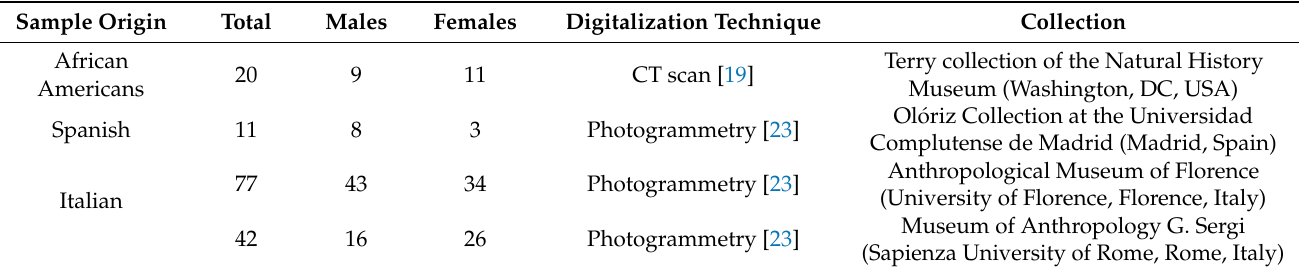
Table 1. Sample analyzed in this study.